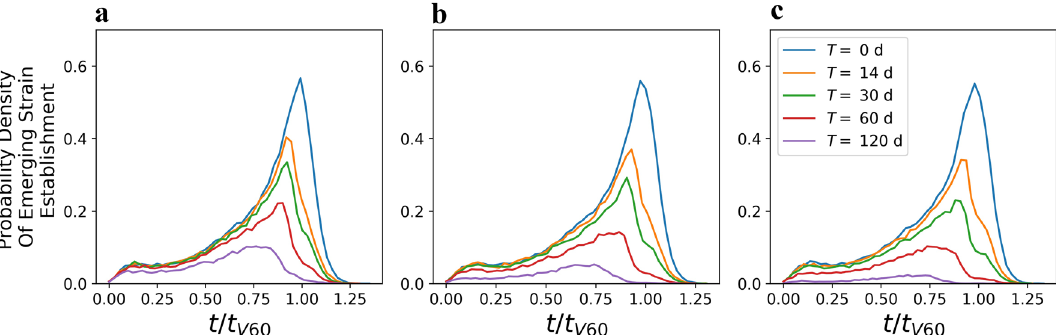
Figure 3. Time of initial emergence of a resistant strain that has become established. Probability density that the resistant strain emerges as a function of time since the start of the simulation, t , rescaled by the time at which 60% of the individuals are vaccinated, t V60 , averaged across simulations with θ (0.001 through 0.015), F h (2000 through 20,000) and p = 10 – 6 . Without any extraordinary periods of low transmission (blue line) the peak of the likelihood of emergence of a new strain is at t/t V 60 = 1. The likelihood of emergence of a resistant strain can be reduced by an extraordinary period of low transmission centered at t / t V60 = 1 with a stronger reduction when such period is longer, T (colour-coded), or when the rate of transmission is more strongly reduced ( a ) β l = 0.055, ( b ) β l = 0.03, ( c ) β l =